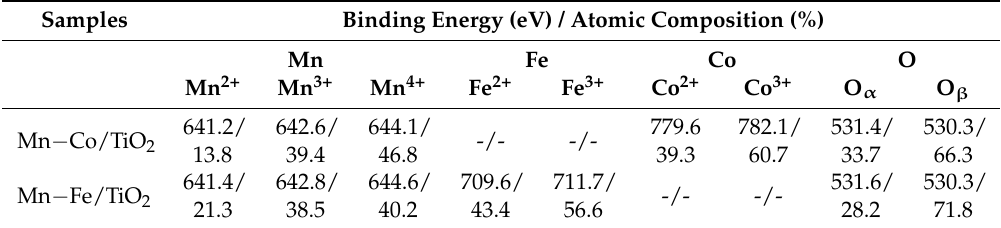
Figure 6. XPS analysis of Mn − Co/TiO 2 and Mn − Fe/TiO 2 nanocatalysts: ( a ) XPS spectra for Ti 2 p ; ( b ) XPS spectra for Mn 2 p ; ( c ) XPS spectra for Co 2 p ; ( d) XPS spectra for Fe 2 p ; ( e ) XPS spectra for O 1 s . Table 4. Surface atomic compositions of the catalysts determined by XPS.